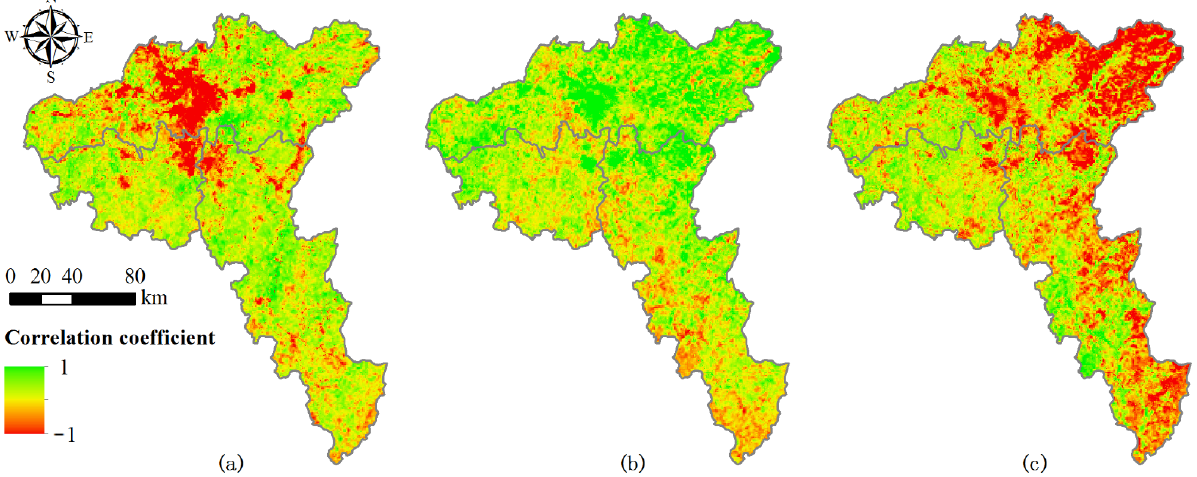
Figure 6. Spearman’s rank correlations between the annual NPP and climate variables in the CZT urban agglomeration from 2000 to 2015. ( a ) NPP–temperature; ( b ) NPP–precipitation; ( c ) NPP–radiation.